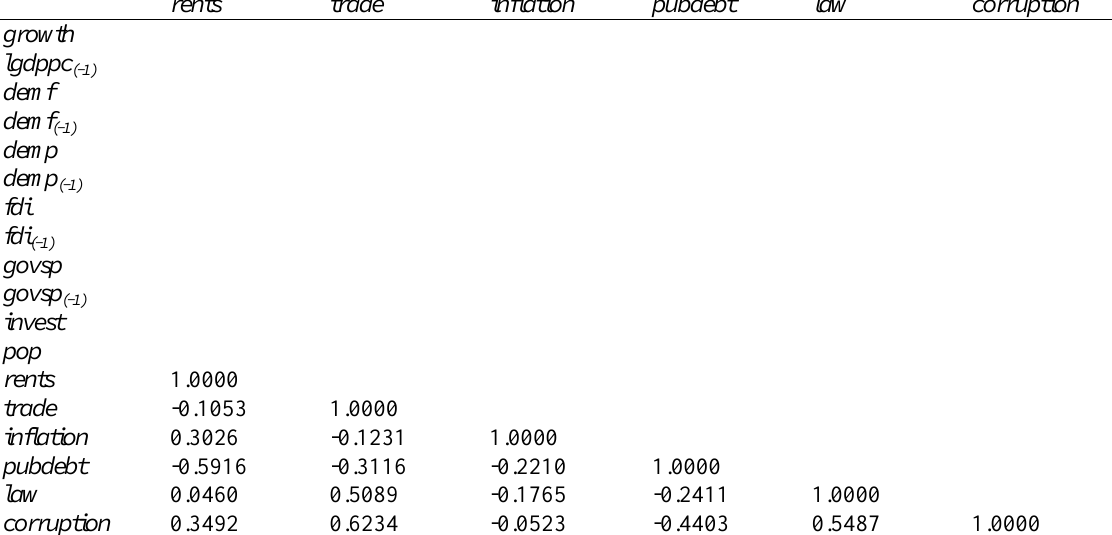
Table A.3: Correlation matrix